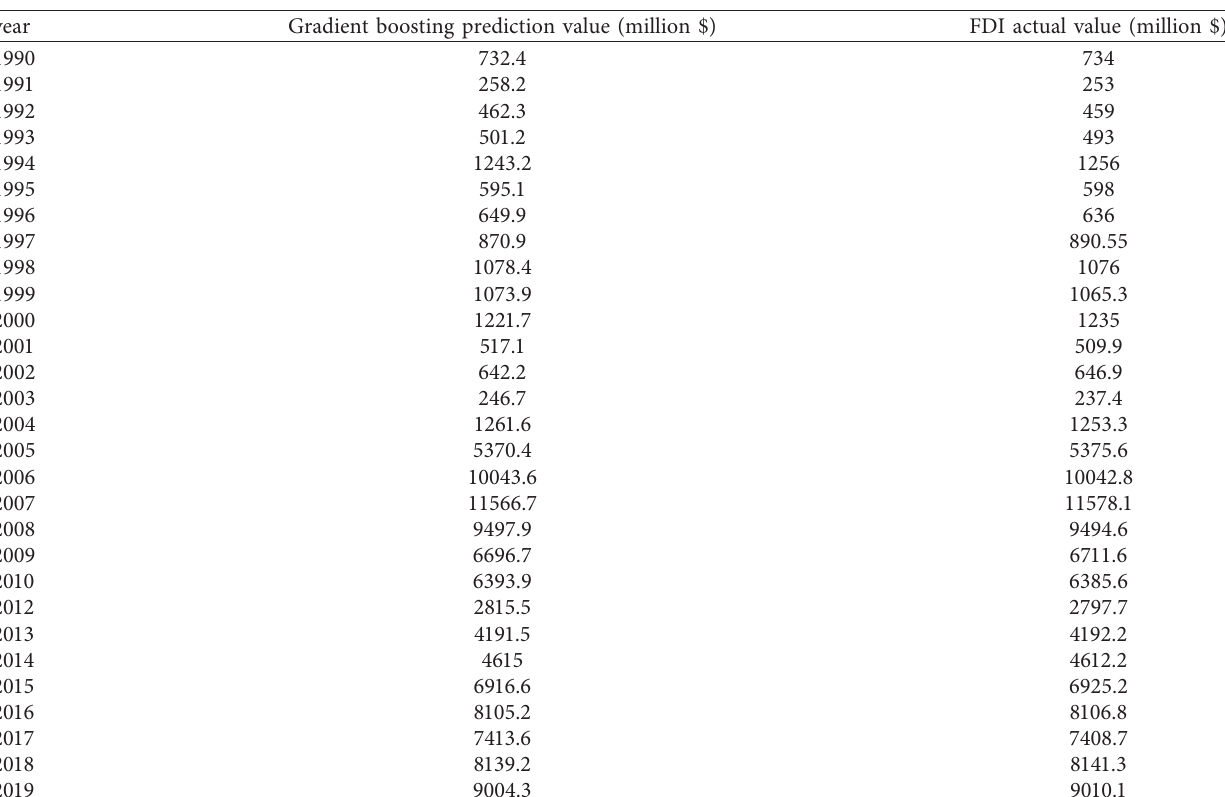
Table 2: Gradient boosting prediction for actual FDI value million $.